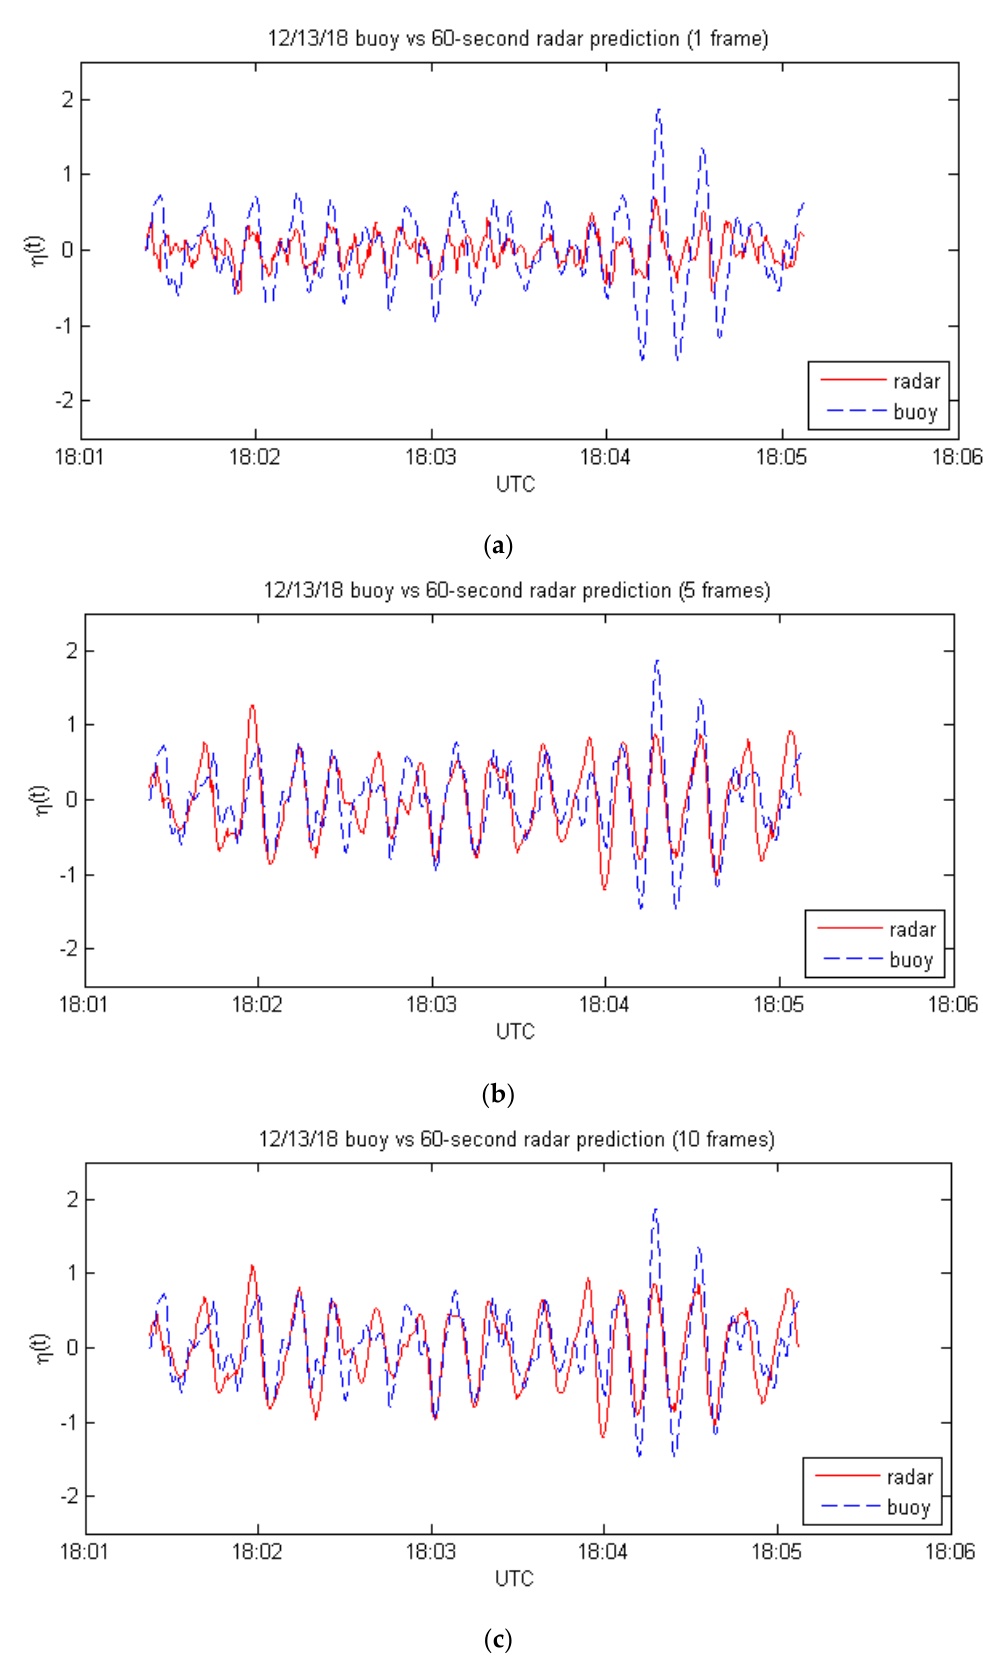
Figure 4. Comparison of buoy measurements with 60 s radar predictions for: ( a ) one frame, from Equation (1); ( b ) 5 frames, from Equation (12); ( c ) 10 frames, from Equation (12).